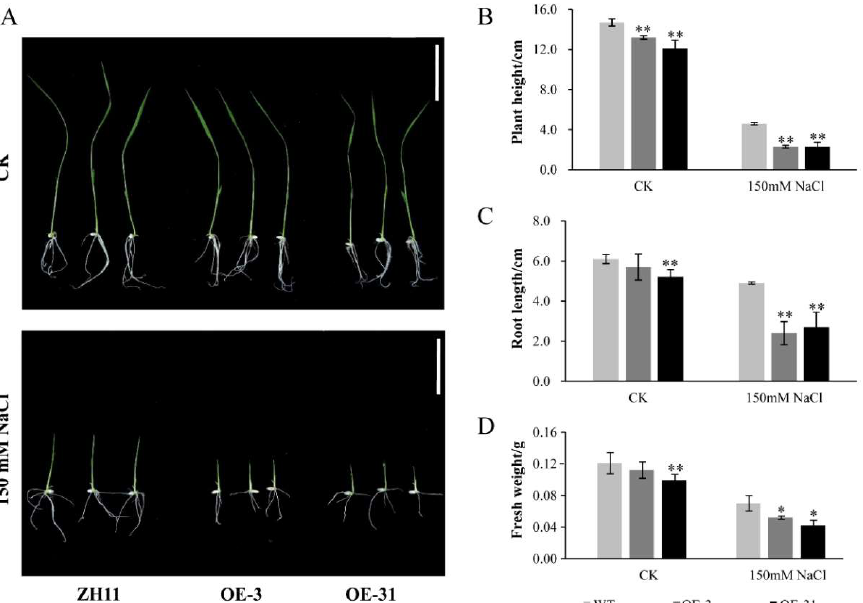
Figure 6. Salt stress tolerance of AcWRKY31 overexpression rice plants. ( A ) Performance of ZH11 and AcWRKY31 overexpression rice plants with or without salt treatment for 10 days; scale bar = 5 cm. The plant height ( B ), root length ( C ) and fresh weight ( D ) of all lines in ( A ). Bars show standard deviations of at least 10 seedlings. Asterisks indicate significant differences between the ZH11 and the AcWRKY31 overexpression lines evaluated with Student’s t test (* p < 0.05, ** p < 0.01). 2.7. Overexpression of AcWRKY31 Decreased Drought and Salt Tolerance in Transgenic Ara- bidopsis Plants In order to investigate whether heterologous overexpression of AcWRKY31 in Ara- bidopsis also has similar function, we generated two AcWRKY31 transgenic Arabidopsis lines, OE-10 and OE-12 (Figure S1B). The seedings of WT, OE-10 and OE-12 were planted in the 1/2 MS medium as the control group. Volumes of 200 and 250 mM mannitol were used to simulate drought treatment. Then, 1/2 MS medium containing 75 mM and 100 mM NaCl was used to mimic salt treatment. The results showed that compared with the WT, the germination rate, root length and fresh weight of OE-10 and OE-12 were de- creased under 200 mM mannitol and 75 mM NaCl treatments, and further decreased un- der 250 mM mannitol and 100 mM NaCl treatments (Figures 7 and 8).